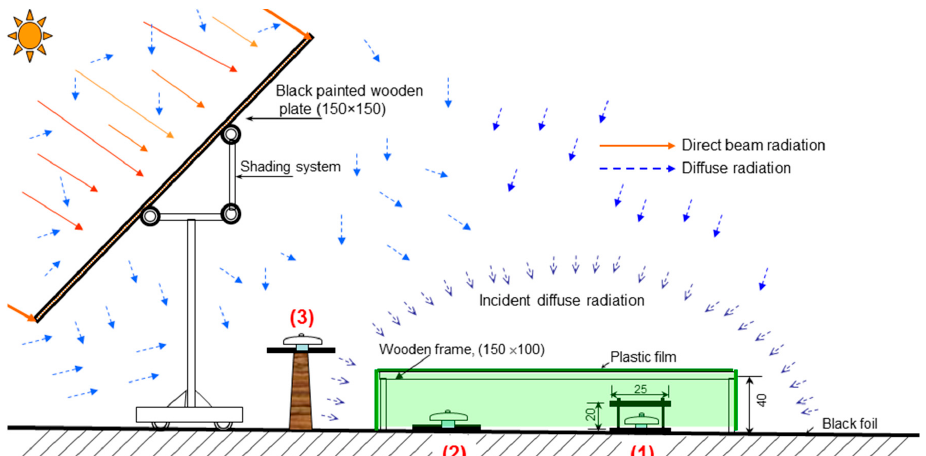
Figure 4. Experimental setup and the shading system used to estimate the correction factors of the shaded pyranometers, and the true transmittance of the film to diffuse solar radiation. Dimensions are in cm, not to scale, and (1), (2) and (3) are the pyranometer numbers.